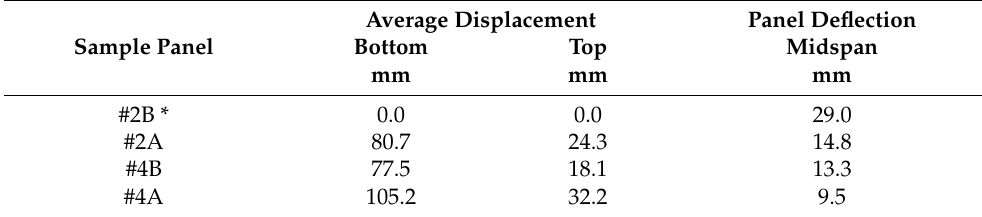
Table 4. Maximum deflections of the panels for serial test #2. Average Displacement Panel Deflection Sample Panel Bottom Top Midspan mm mm